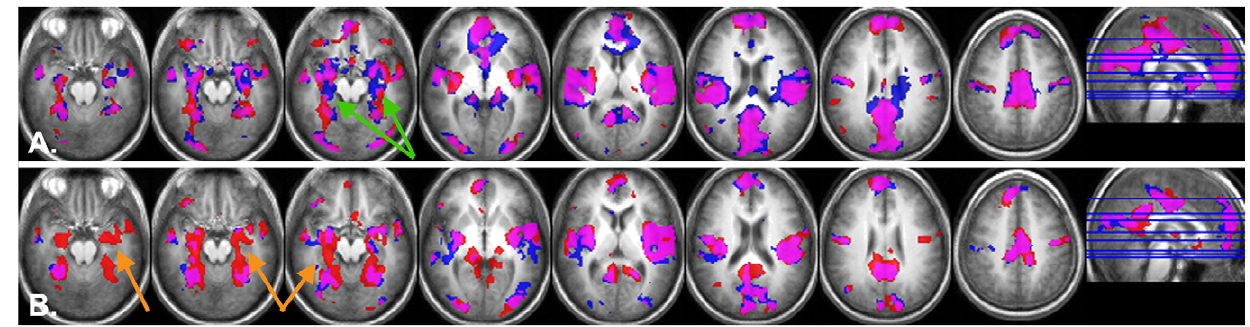
Figure 2. Brain regions showing significant task-related deactivation in the 0vs3-back contrast in A) 1) CPAP group at baseline AND HC (red); 2) CPAP group post-treatment AND HC (blue; purple indicates overlap between 1 and 2); and in B) sham-CPAP group at baseline AND HC (red); 2) sham-CPAP group post-treatment AND HC (blue; purple indicates overlap between 1 and 2). Green arrows indicate increased deactivation in the tDMN after CPAP treatment (regions in blue), orange arrows indicate decreased deactivation in the tDMN after sham-CPAP treatment (regions in red) (neurological presentation, p , 0.05, FDR corrected for multiple comparisons).